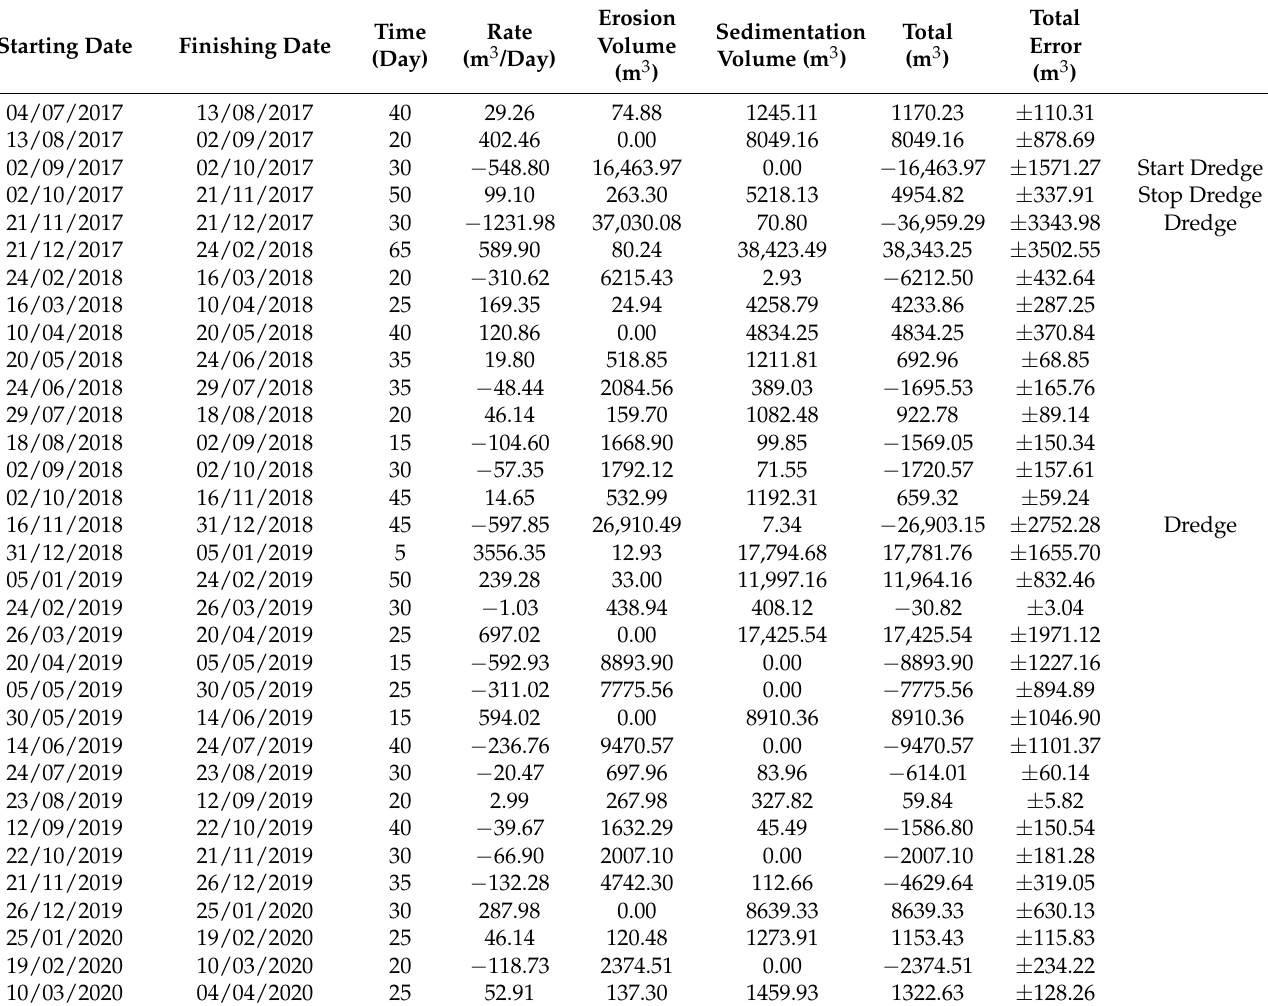
Table 4. Evolution of sedimentation in the Port of